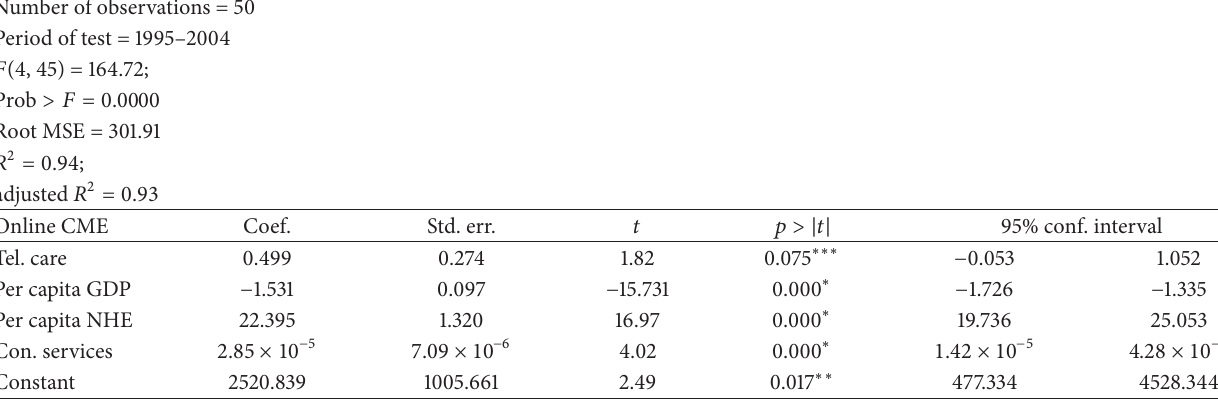
Table 2: Regressions of online CME on selected variables.